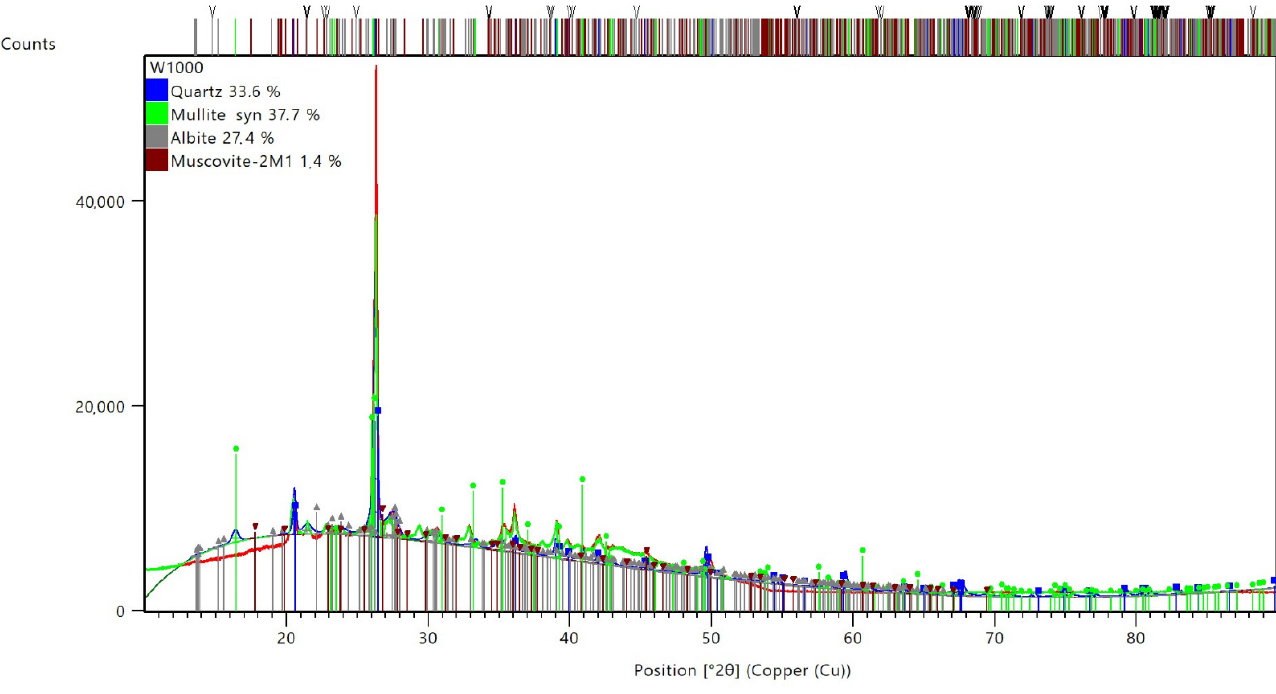
Figure 12. XRD of heated to 1000 ◦ C coal gangue geopolymer foam A1-1.